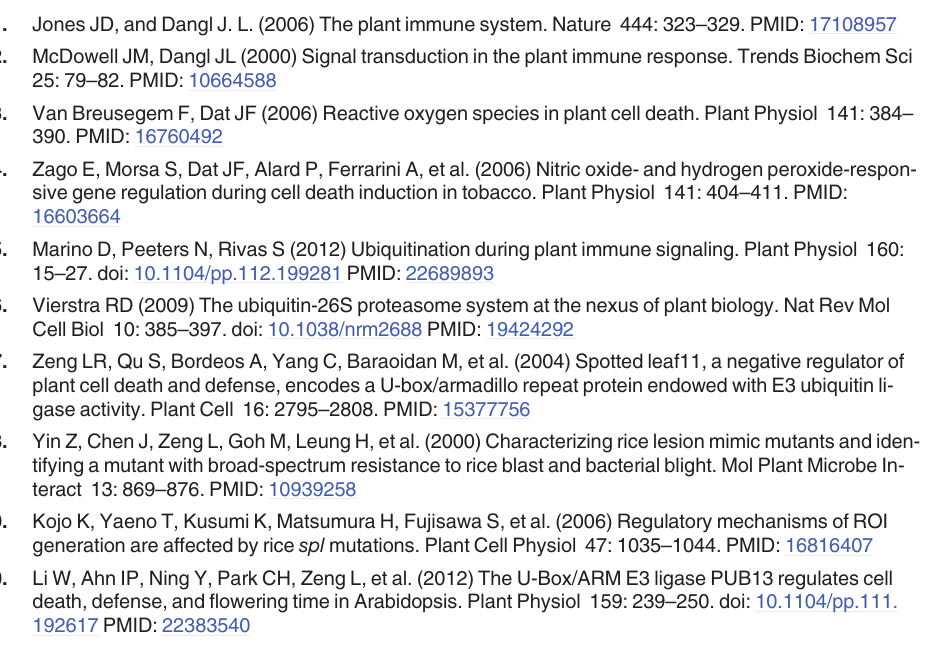
S2 Text. Supporting information tables. Table S1. The cDNA sequence identity of Spin6 and its two rice homologous genes. Table S2. The protein sequence identity of SPIN6 and its two rice homologous genes. Table S3. Primers used in this